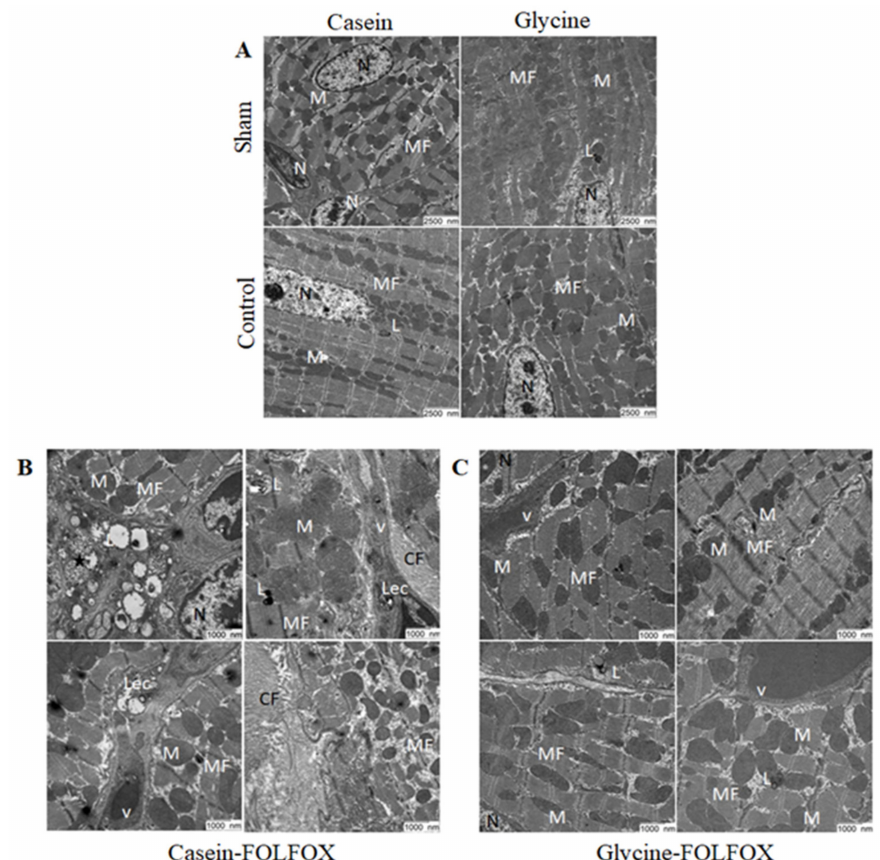
Figure 7. Transmission electron microscopy scans of heart samples. Representative pictures of hearts scanned by electron microscopy in ( A ) groups without FOLFOX (Casein–Sham, Glycine–Sham, Casein–Control, Glycine–Control) at magnification 7000 × ; ( B ) Casein–FOLFOX; and ( C ) Glycine–FOLFOX groups at magnification 12,000 × . FOLFOX induced a significant increase of the collagen fibers in the heart muscle, and lysosomes within the endothelial cells were observed in the Casein–FOLFOX group. Glycine prevented FOLFOX-induced ultrastructural changes. MF—myofibrils; M—mitochondria; N—nucleus, L—lysosomes; Lec—lysosomes within endothelial cells; asterisk—lysosomes containing dark granules and other lipids; v—vessels; CF—collagen fibers.